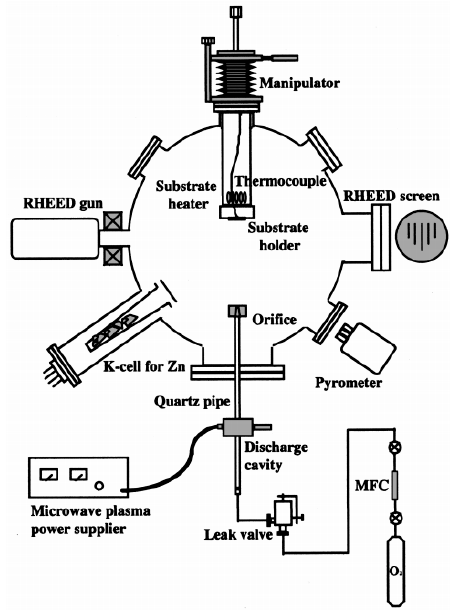
Figure 5. Schematic diagram of the MBE system. Reproduced with the permission from American Institute of Physics in the Ref [63].